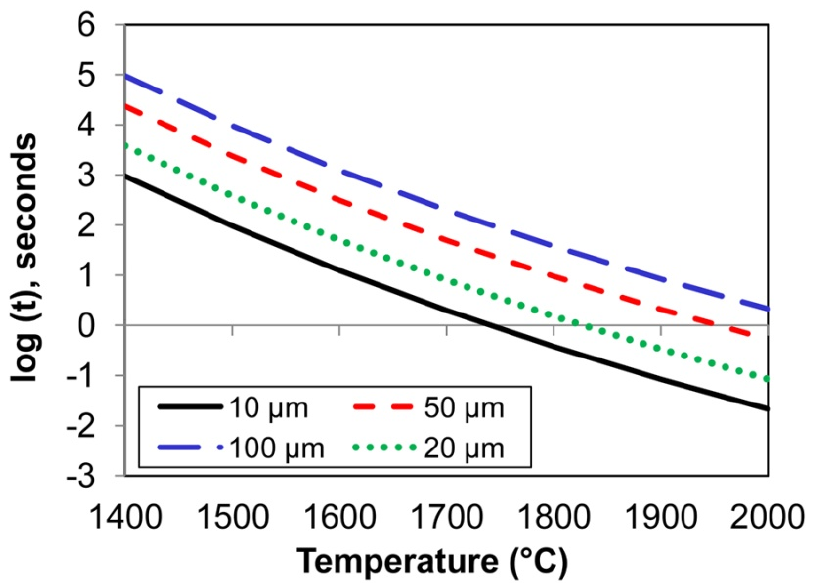
Figure 8. Estimated spinel growth rates calculated from the growth equation in reference [47].